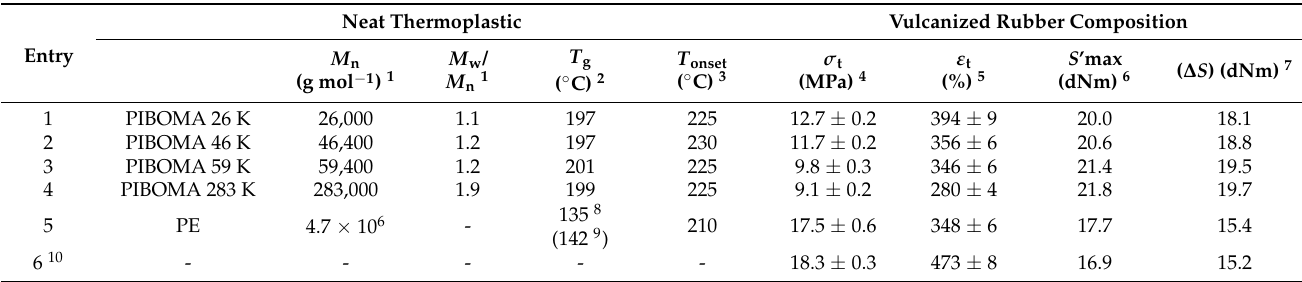
Table 3. Selected properties of thermoplastic polymers and vulcanized rubber compounds reinforced with them (the loading of thermoplastic in rubber composition was always kept at 20 phr level).